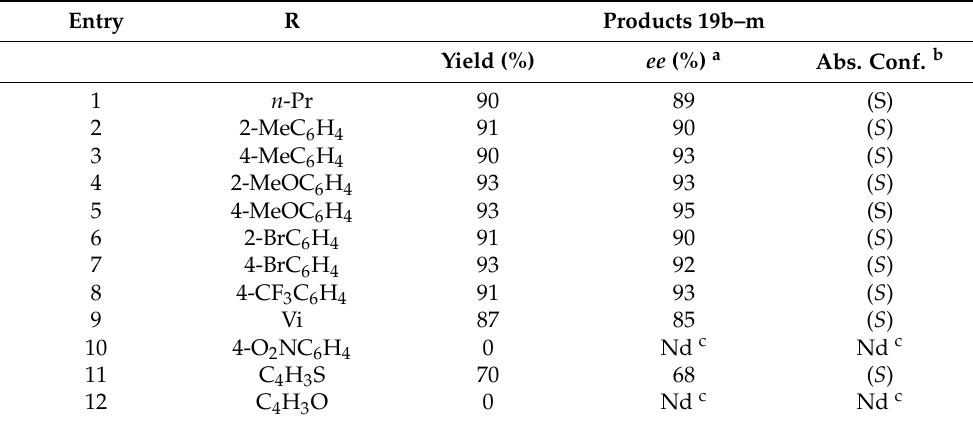
Table 4. Asymmetric addition of Et 2 Zn to aldehydes in the presence of 6